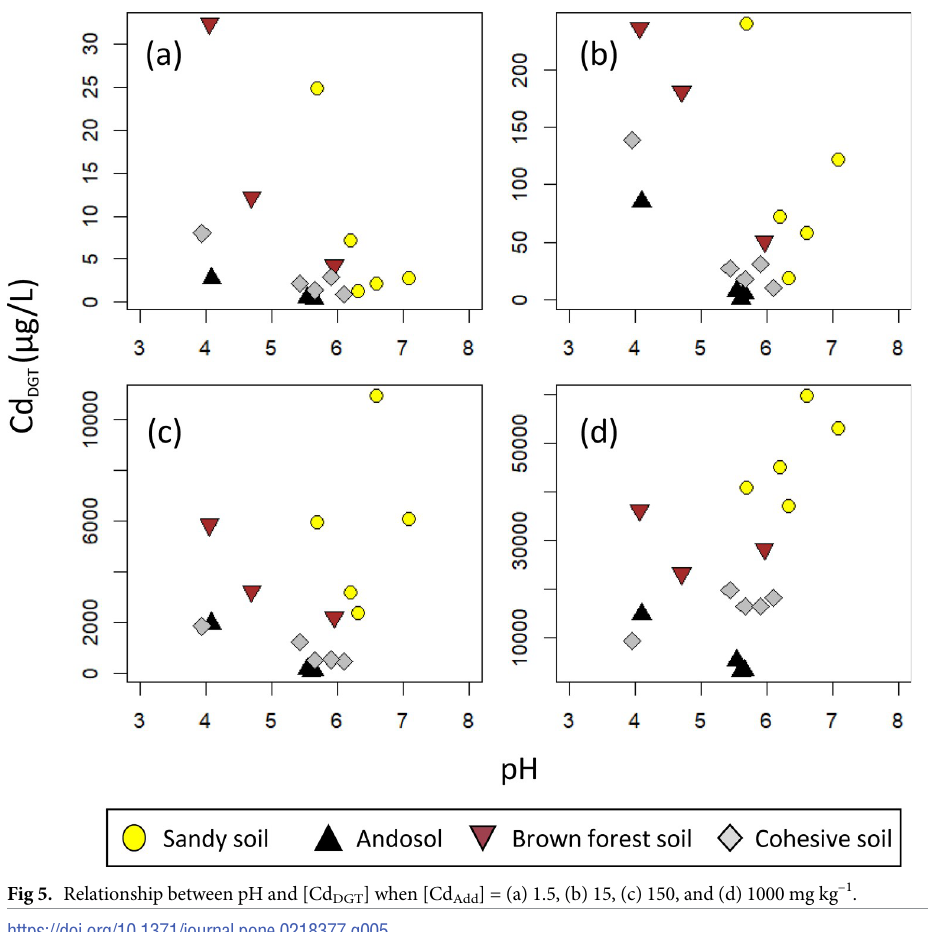
Fig 5. Relationship between pH and [Cd DGT ] when [Cd Add ] = (a) 1.5, (b) 15, (c) 150, and (d) 1000 mg kg –1 .